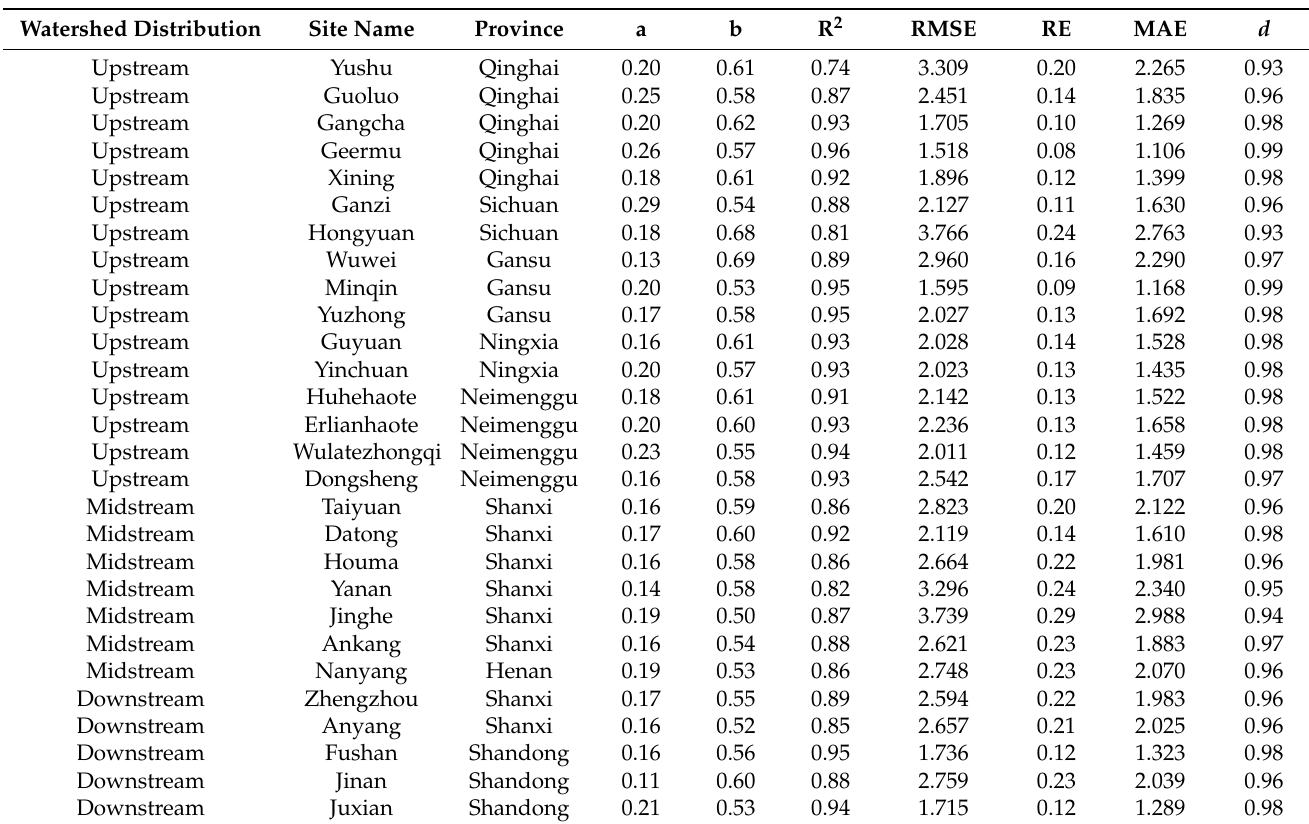
Table 2. Å-P parameter calibration and performance evaluation of each